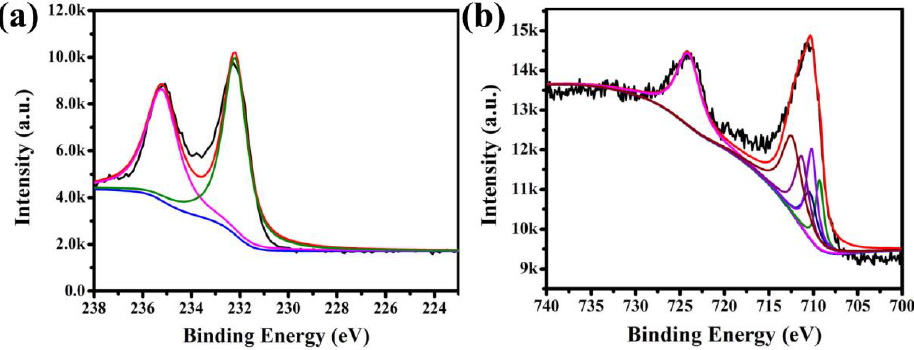
Figure 5. XPS spectra of the Fe 3 O 4 @1 : ( a ) Mo 3d spectrum and ( b ) Fe 2p spectrum.